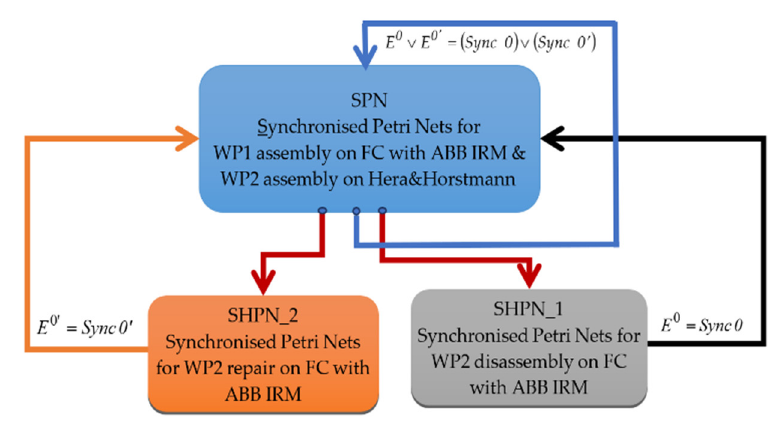
Figure 12. Synchronization and integration of SHPN Model.